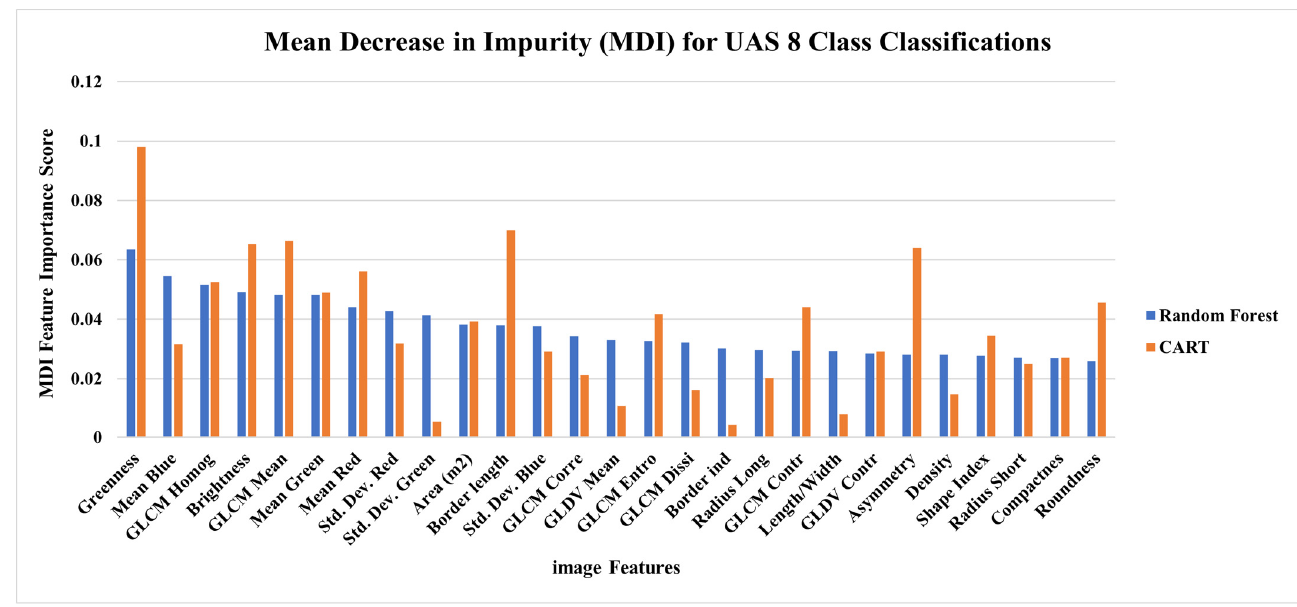
Figure A1. Feature importance for NAIP imagery classification of eight composition classes calculated using the mean decrease in impurity (MDI) test.